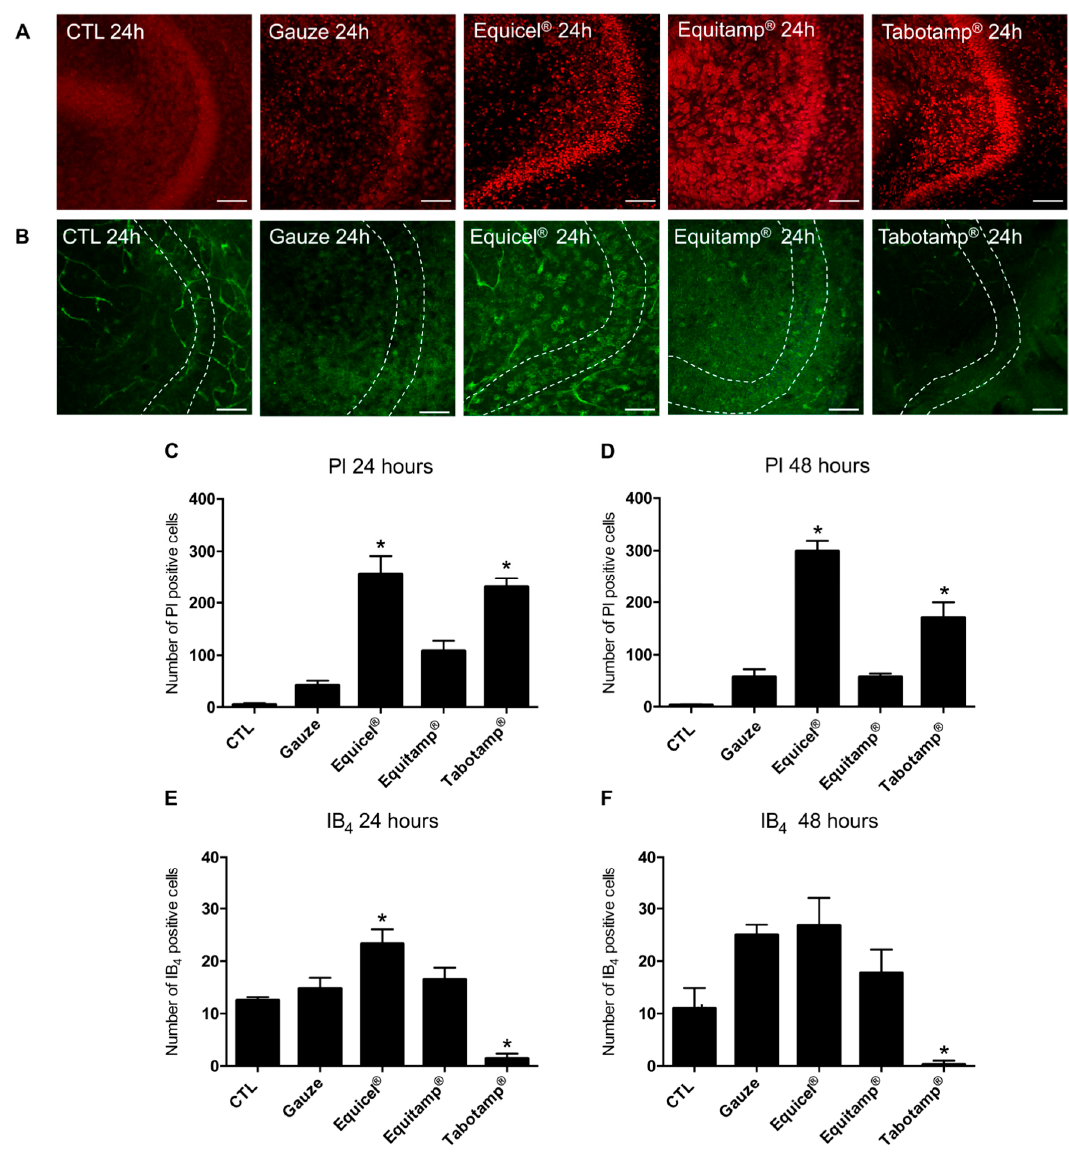
Figure 4. Effects of treatment with Equicel ® , Equitamp ® and Tabotamp ® on cell viability and microglia activation in OHSC after 24 and 48 h. PI staining (red) of OHSC as recorded by confocal laser scanning microscopy representing dentate gyrus (DG) with granule cells (24 h results displayed) ( A ). Treatment with Equicel ® and Tabotamp ® led to intense red stained PI positive nuclei in DG regions. Equitamp ® caused a mild accumulation of PI in the cells of the DG. IB 4 staining (green) of OHSC recorded by confocal laser scanning microscopy representing microglia cells and remaining vessels. In CTL, only isolated ramified microglia cells were visible. Treatment with Equicel ® led to increase of amoeboid microglia cells in the DG. Dotted lines mark the borders of GCL ( B ). Quantitative analysis of the number of PI positive degenerating cells in GCL ( C , D ). Equicel ® (* p < 0.001) and Tabotamp ® (* p < 0.01) induced a significant increase of PI positive cells in GCL 24 h after treatment compared gauze ( C ). Similar results were obtained for Equicel ® (* p < 0.001) and Tabotamp ® (* p < 0.01) compared to the OHSC treated with gauze after 48 h ( D ). Quantitative analysis of the number of IB 4 positive microglia cells in GCL ( E , F ). After 24 h incubation with Equicel ® , a significant increase in IB 4 positive microglia in the DG compared to the gauze was observed (*, p < 0.05). A clearly reduced number of IB 4 positive microglia was detected for Tabotamp ® compared to gauze (* p < 0.001) ( E ). After 48 h no significant difference in IB 4 positive microglia cells between Equicel ® and gauze was detectable ( F ). A general increase in the number of microglia was found in treated groups compared to the results after 24 h (CTL compared to gauze: * p < 0.001 after 48 h). For Tabotamp ® , a significant reduction of microglia was present after 48 h compared to gauze (* p < 0.001). For a statistical comparison of all groups, see Table S2. Bar = 100 µm. 2.4. The Increased Cellular Damage of Equicel ® and Tabotamp ® Persisted after 48 h in OHSC